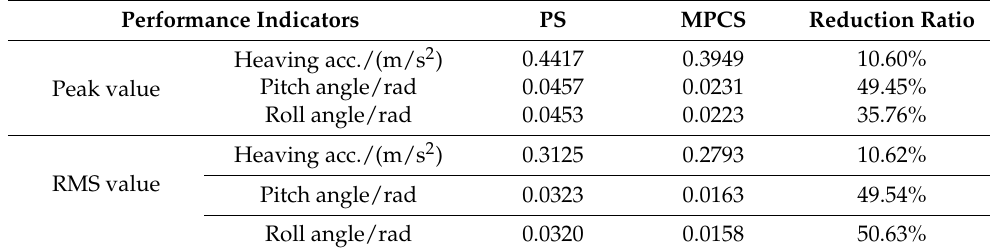
Table 4. Simulation Results of Peak Value and RMS Value of Attitude Stability Control Under Sinusoidal Road Disturbances.